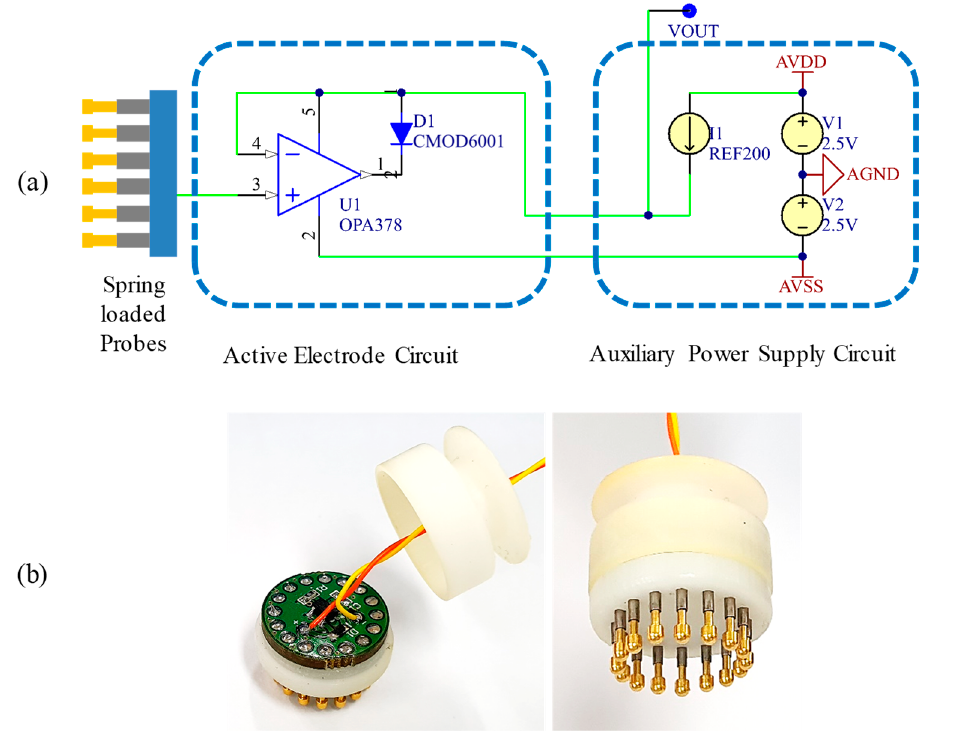
Figure 3. Actual implemented schematic ( a ) and images ( b ) of the proposed active dry electrode. The proposed electrode system comprises the electrode unit itself and an auxiliary circuit board for the voltage and current power supplies. In the electrical schematic, decoupling capacitors for stabilized voltage supplies are omitted for simplicity.